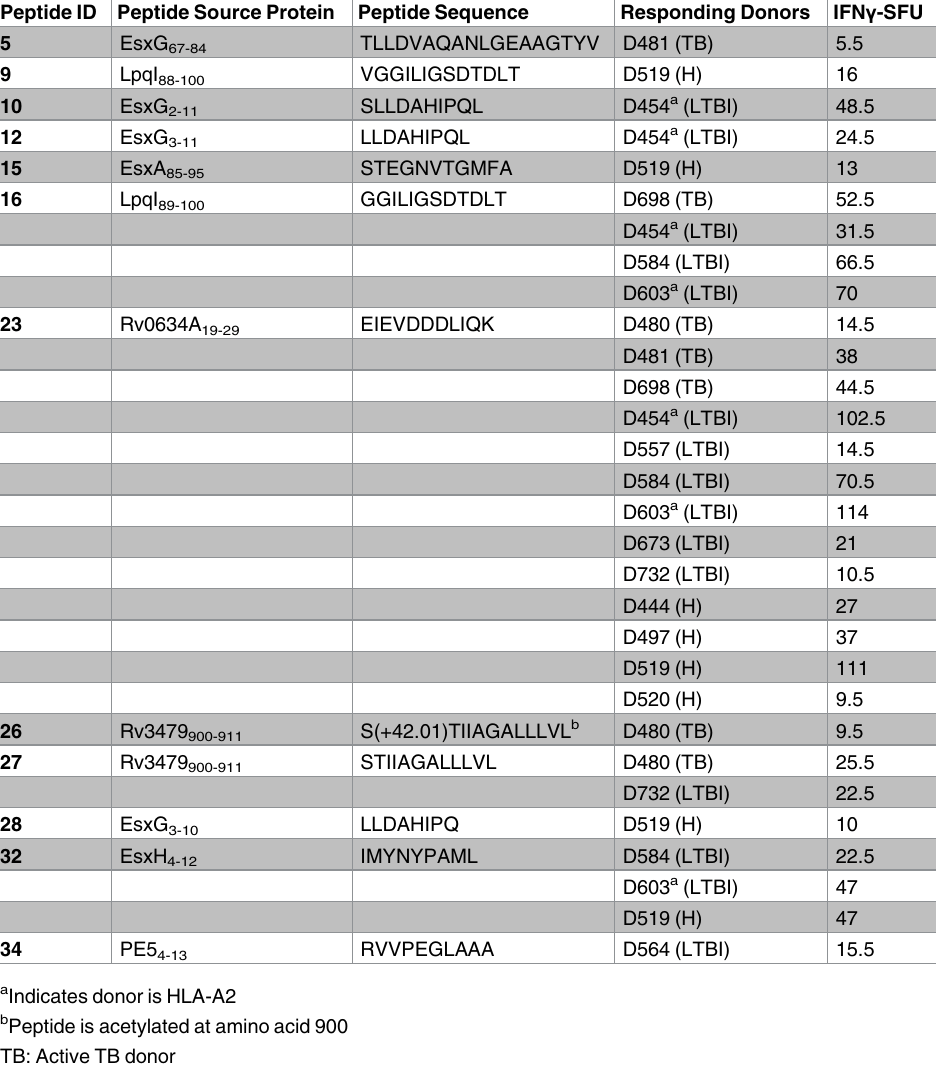
Table 3. Responses from 250,000CD8 + T cells ex vivo to peptide-pulsed autologous DC. Peptide ID Peptide Source Protein Peptide